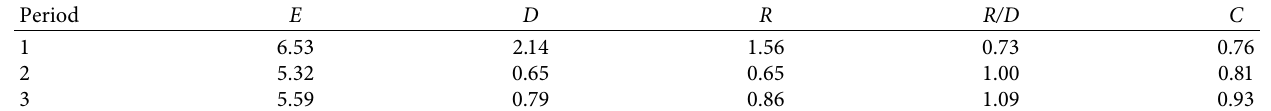
Table 5: Air trafc situation network indicators in three periods.